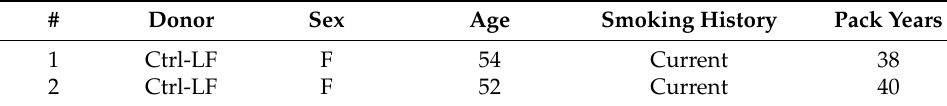
Table 2. Characteristics of fibroblasts